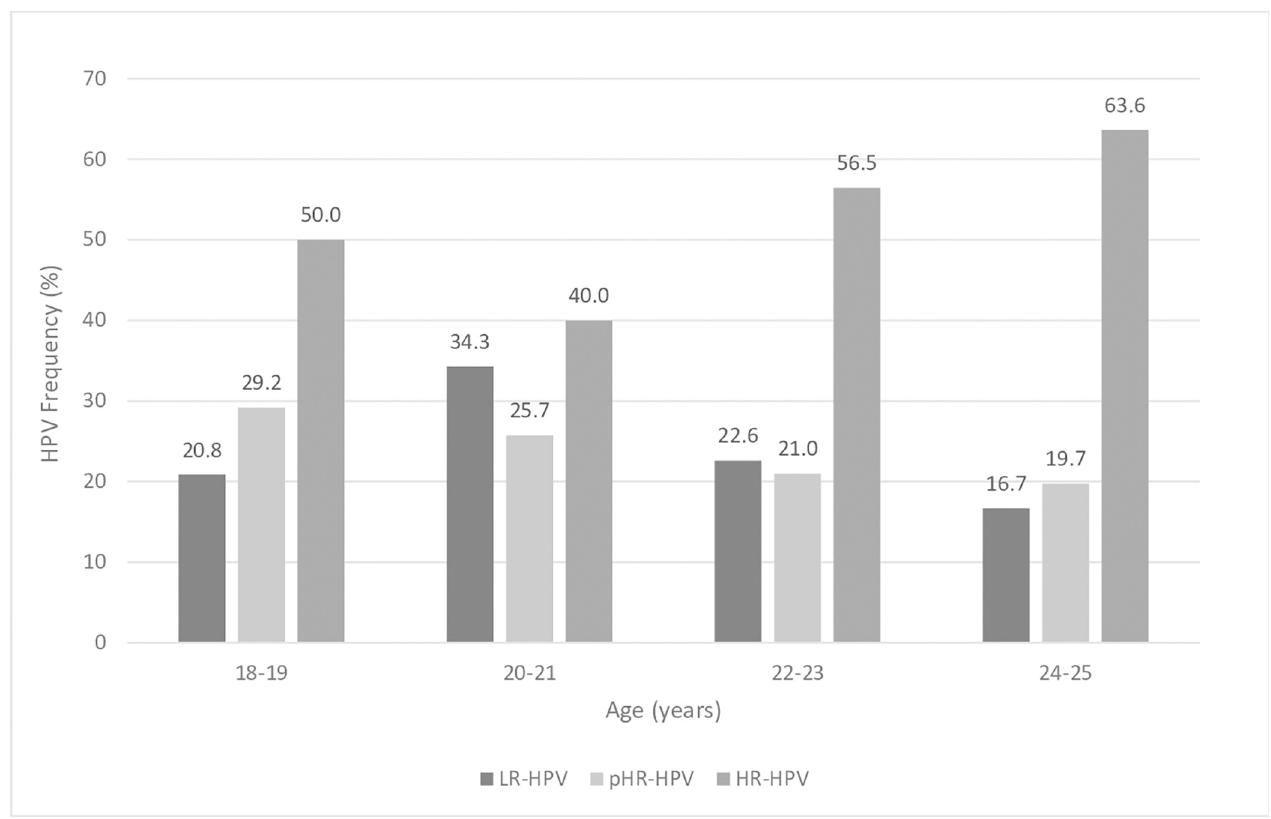
Fig 1. Frequency of HR-HPV, pHR-HPV, and LR-HPV in young women from Paraguay (N = 208). HR-HPV: High risk HPV types; pHR-HPV: possible high risk; and LR-HPV: low risk HPV types. HR types, including Group 1 IARC, carcinogenic to humans (HPV16, 18, 31, 33, 35, 39, 45, 51, 52, 56, 58, and 59) and Group 2A IARC, probable carcinogenic to humans (HPV68). pHR types, Group 2B IARC, possible carcinogenic to humans (HPV26, 30, 34, 53, 66, 67, 69, 70, 73, 82, 85, and 97). LR types, non-carcinogenic to humans (HPV6, 11, 40, 42, 54, 61, 71, 72, 81, 83, and 84).